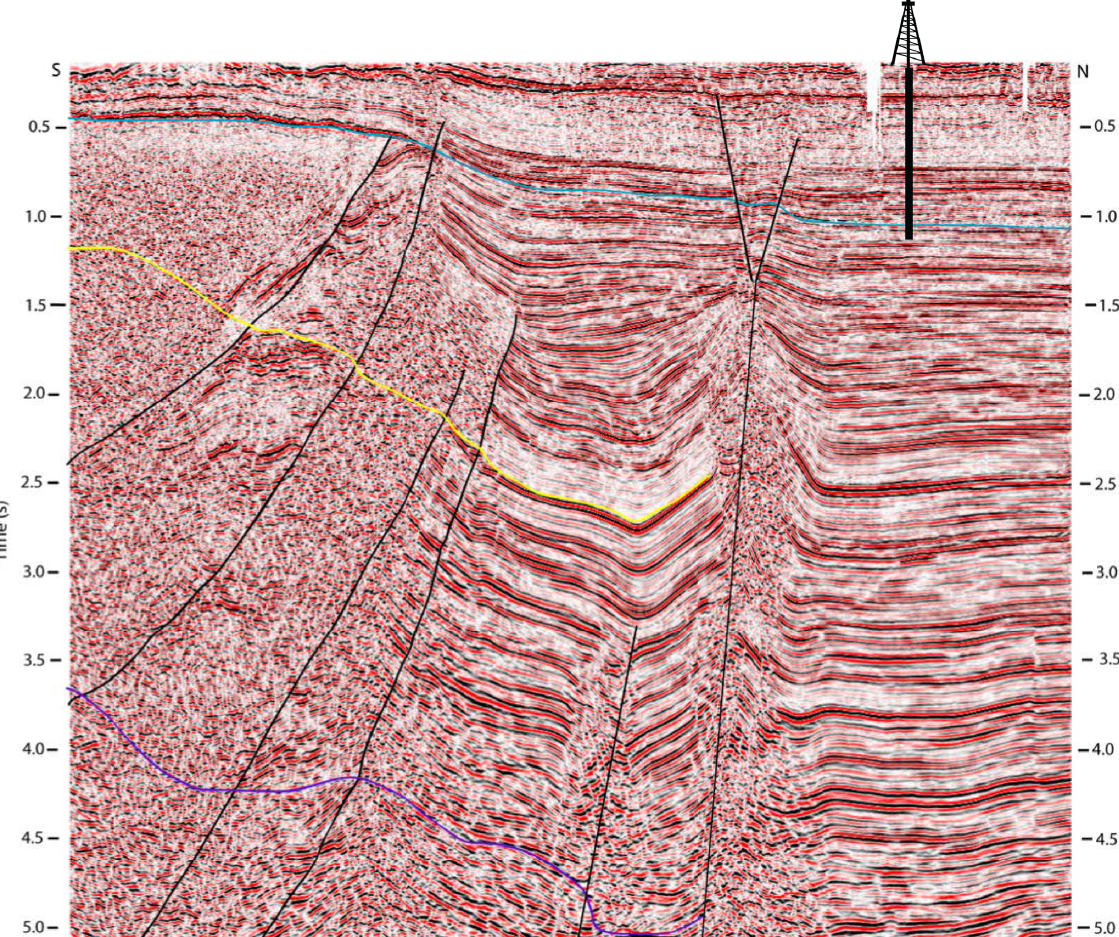
Figure 7. Vertical time slice from a 3D seismic volume acquired across the Frontal Fault zone of the Wichita–Anadarko system, extending from the (subsurface) Wichita Uplift (left) into the deep Anadarko Basin (right). See Fig. 6 for the approximate location of the line (line length ∼ 60km). Vertical scale shows two-way travel time (seconds). Stratal markers as follows: base Pennsylvanian – yellow, base Permian – blue. From Rondot (2009). A potential (basinal) drill site is indicated with the derrick